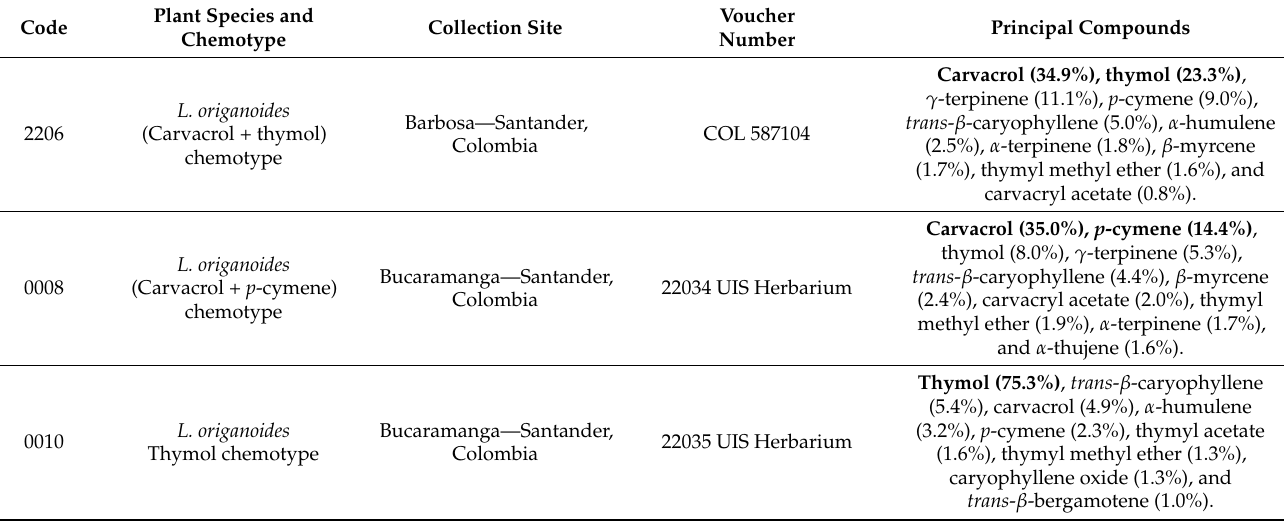
Table 1. Plant information, chemotypes, and chemical compositions of the most active